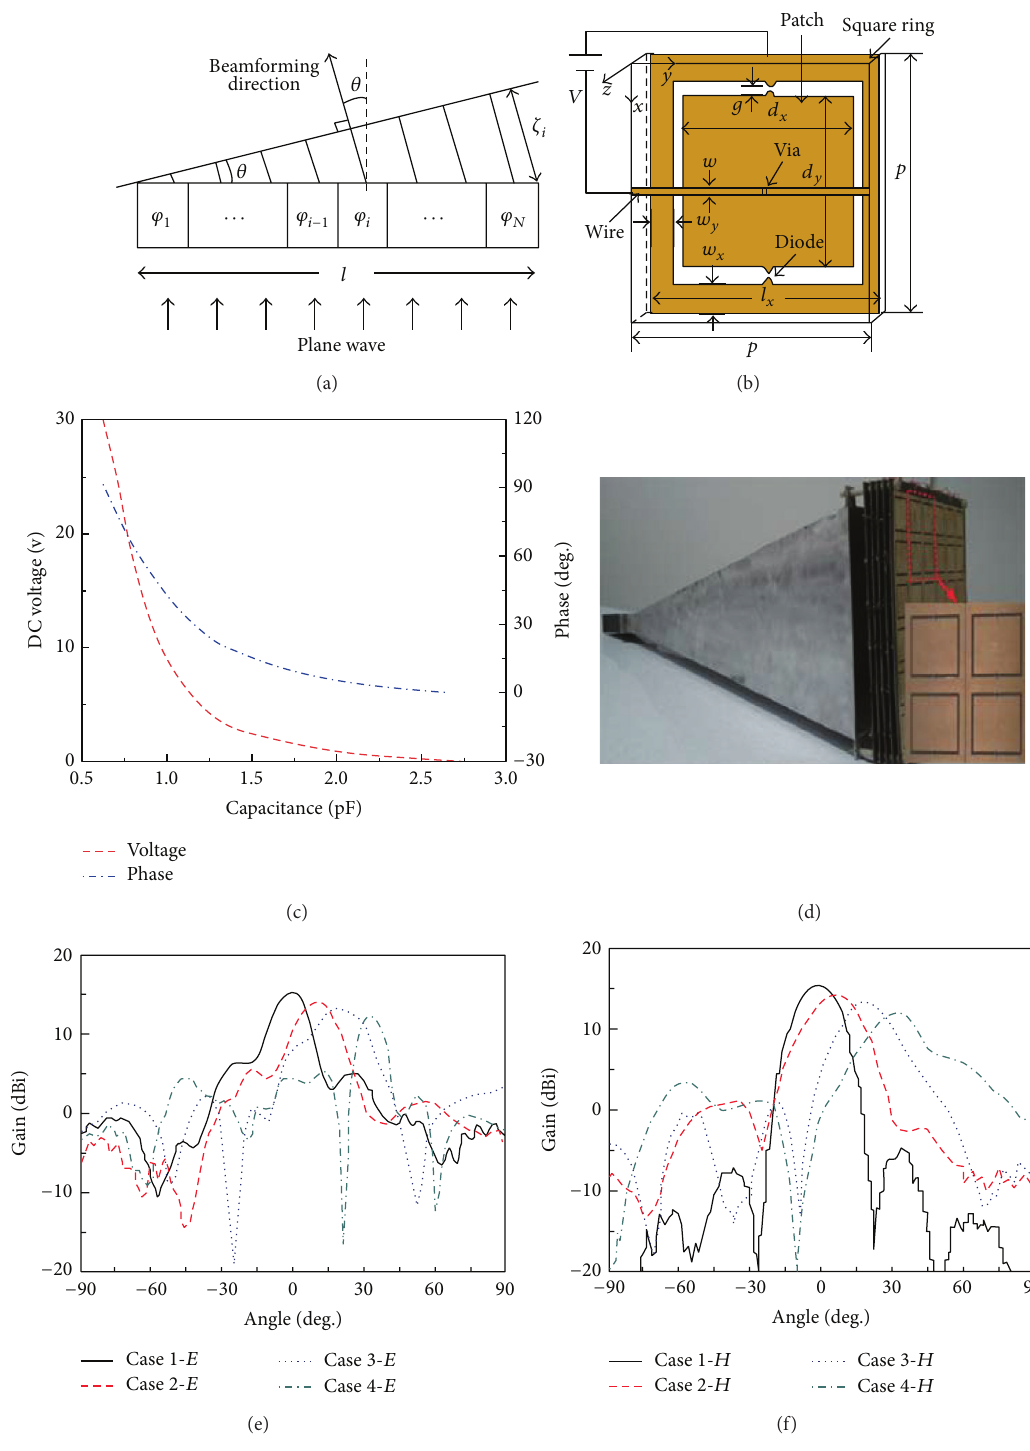
Figure 40: (a) Principle of beam steering. (b) Unit cell of the phase reconfigurable metasurface. (c) Phase manipulation results of the active metasurface. (d) Photography of the horn antenna with the active FSS. (e, f) Radiation patterns of the designed horn antenna in (e) 𝐸 -plane and (f) 𝐻 -plane for different phase distribution. Figures are reproduced from